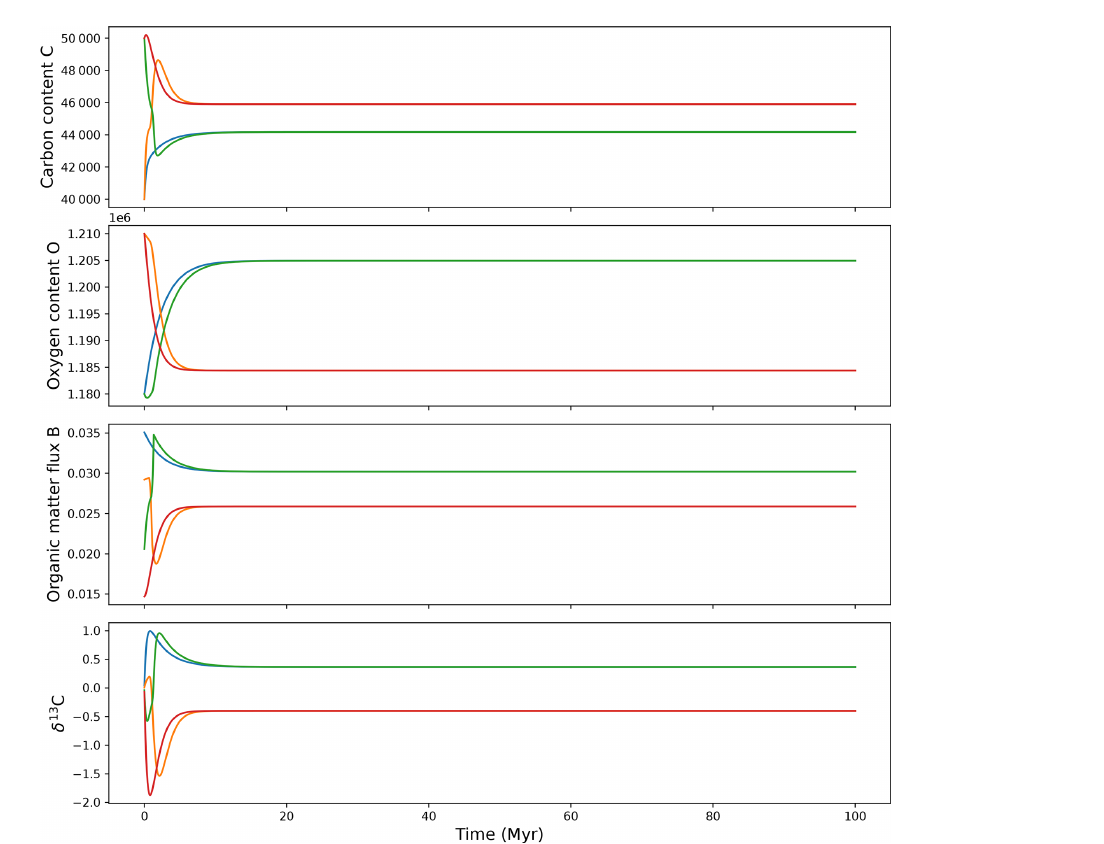
Figure 4. Modelled carbon content, C; oxygen content, O; organic matter flux, B ; and δ 13 C evolution in the case without astronomical forcing for different initial states. Case a > a lim